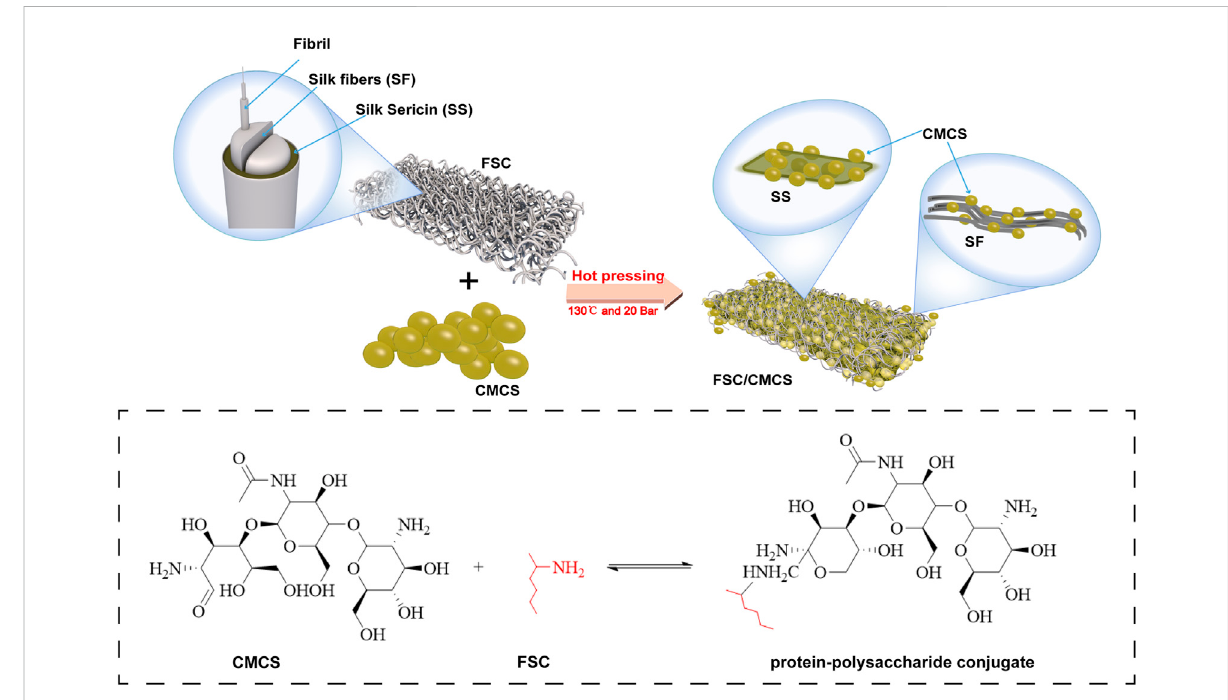
FIGURE 8 schematicmechanisminterpretationoftheFSC/CMCSmembrane,protein – polysaccharideconjugatesareformedbyhotpressingtogenerate a Maillard